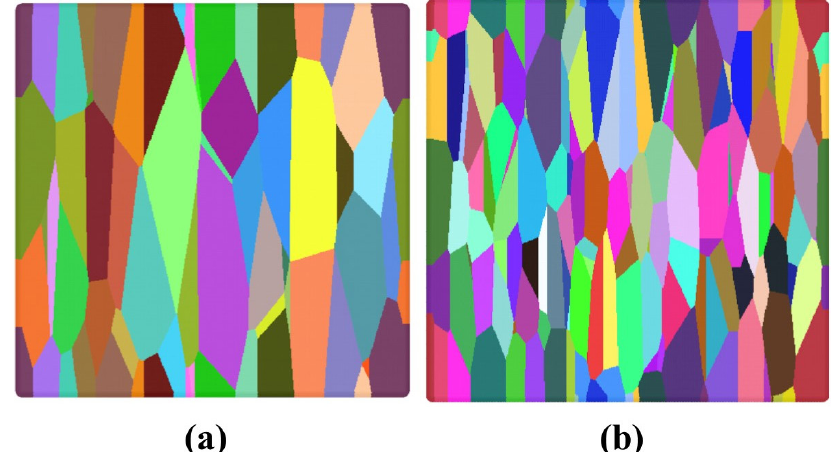
Figure 4. Longitudinal section showing the fully transformed microstructure of prolate ellipsoids nucleated on 20 random parallel planes. The ratio of the length of the shorter axes of the ellipsoid the longer axis of the ellipsoid is 1:1:4. The nucleation was site-saturated. That is, all nuclei started to grow at the time origin: t 0 = . The figures depict microstructures that show the effect of the number of nuclei per plane corresponding: a) 20 nuclei on each plane; b) 80 nuclei on each plane.